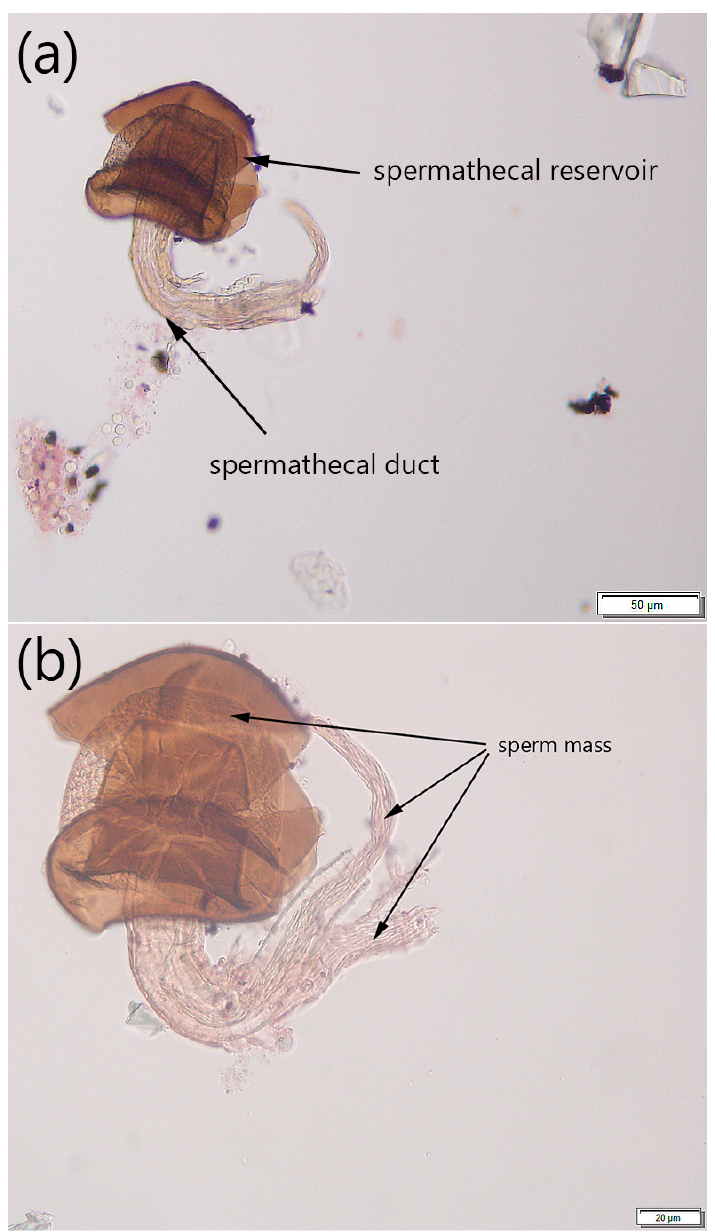
Figure 5. Spermathecae isolated from field collected Drosophila suzukii females. ( a ) Intact spermatheca (at 20× objective lens; the scale is 50 µm); ( b ) Crushed spermathecae with toroidal sperm mass indicated (at 40× objective lens; the scale is 20 µm) (Images by Claire Mattmiller).